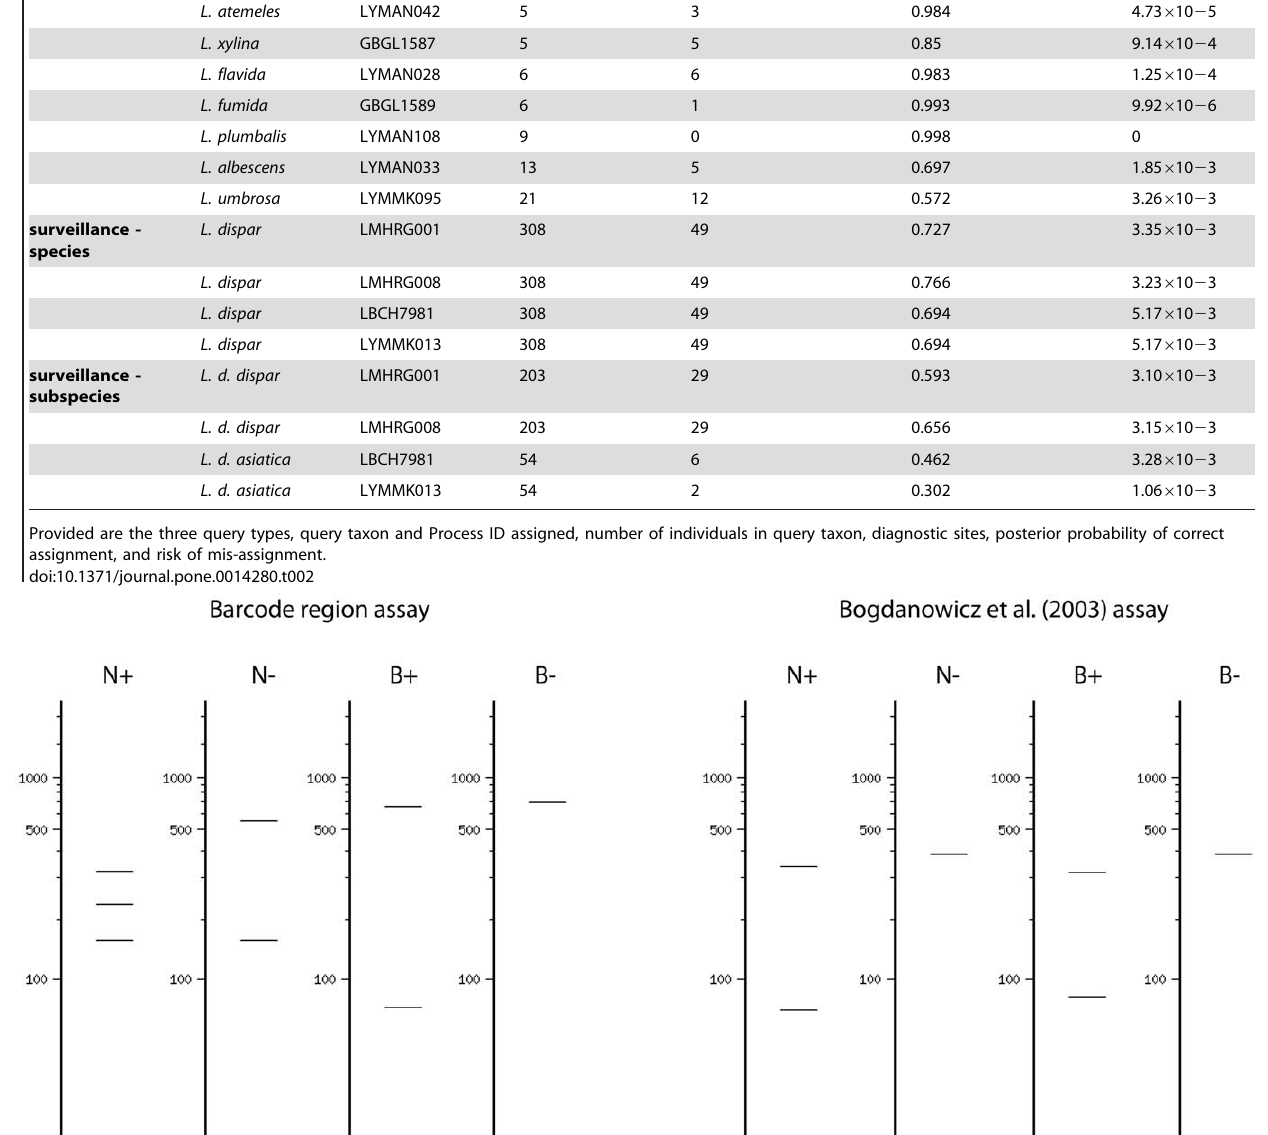
surveillance - species